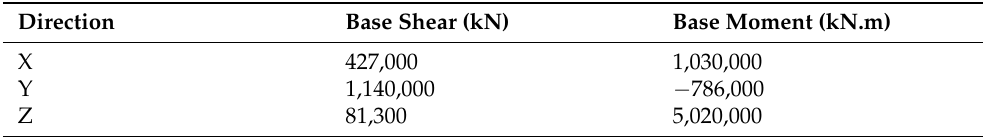
Table 8. Base shear and moment using SRSS.